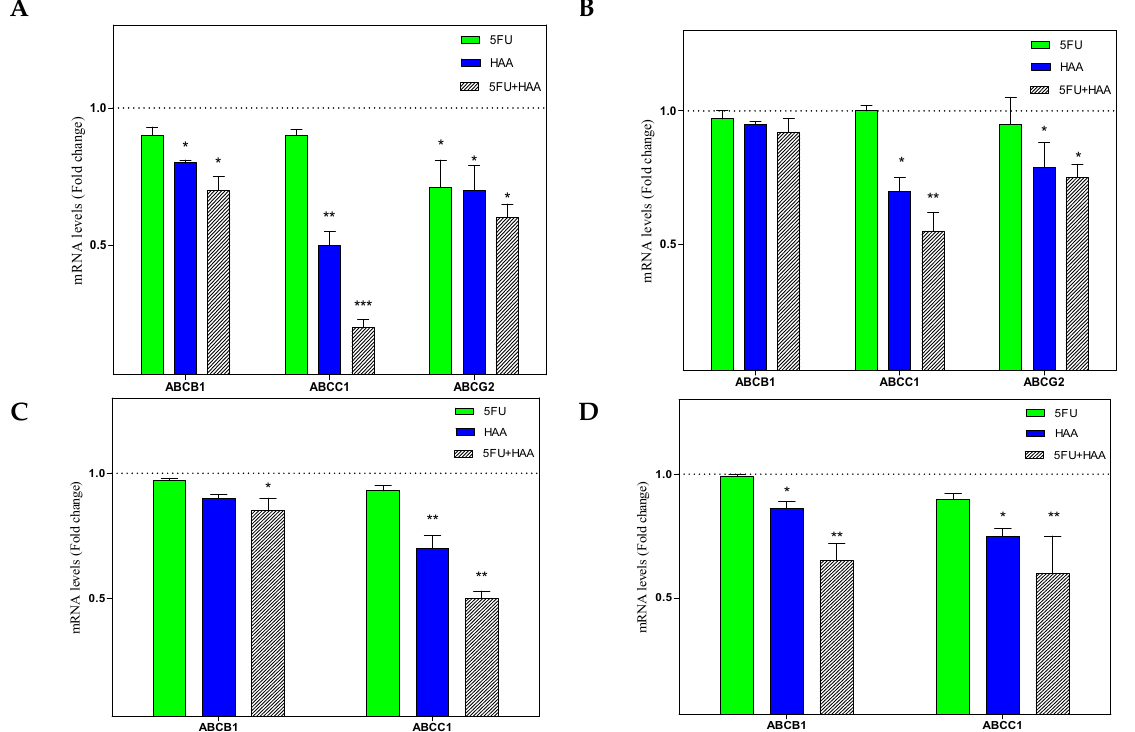
Figure 6. The inhibitory effect (72 h) of vehicle control, 5FU (0.25 µM), HAA 2020 (3 µM), or their combination on the expression of mRNA of ABCB1, ABCC1, and ABCG2 in ( A ) HT29, ( B ) HT29-5FU, ( C ) HCT116, and ( D ) HCT116-5FU cells was quantified by RT-PCR. The data represent the mean ± SD of the fold change related to vehicle control (fold change = 1 dashed line, n = 2, ×2 independent experiments). p < 0.05 (*), p < 0.01 (**), and p < 0.001 (***) were considered significant.